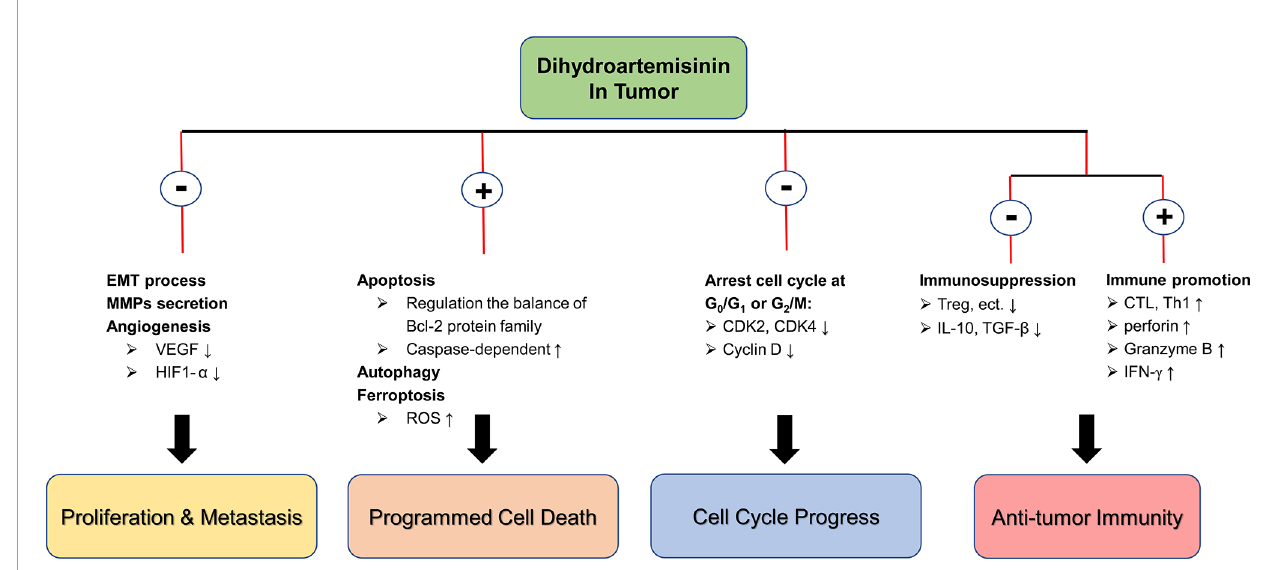
FIGURE 1 | The molecular mechanism of DHA in anti-tumor. ⊕ means the promoting effect of DHA. ⊖ means the suppressive effect of